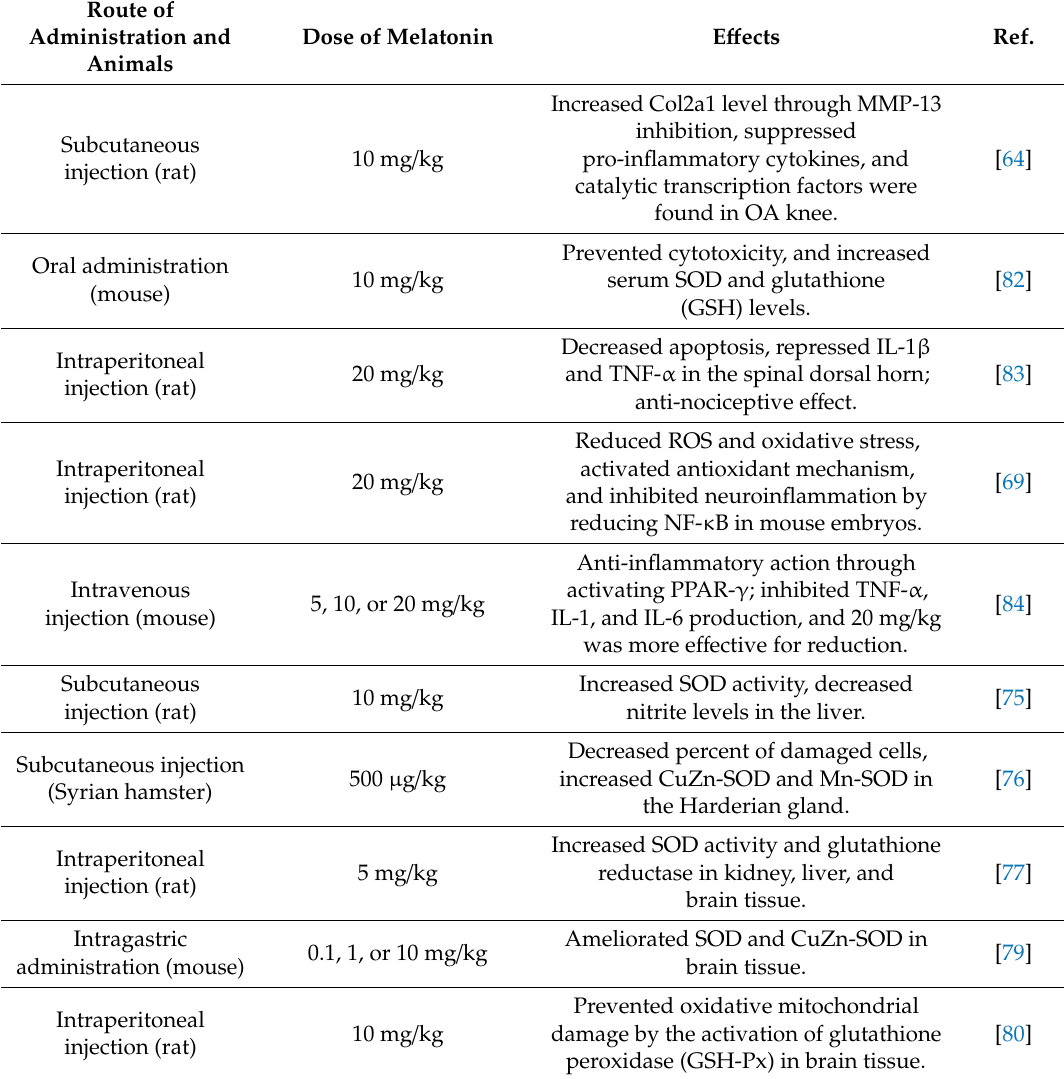
Table 2. E ff ects of various doses of melatonin (in